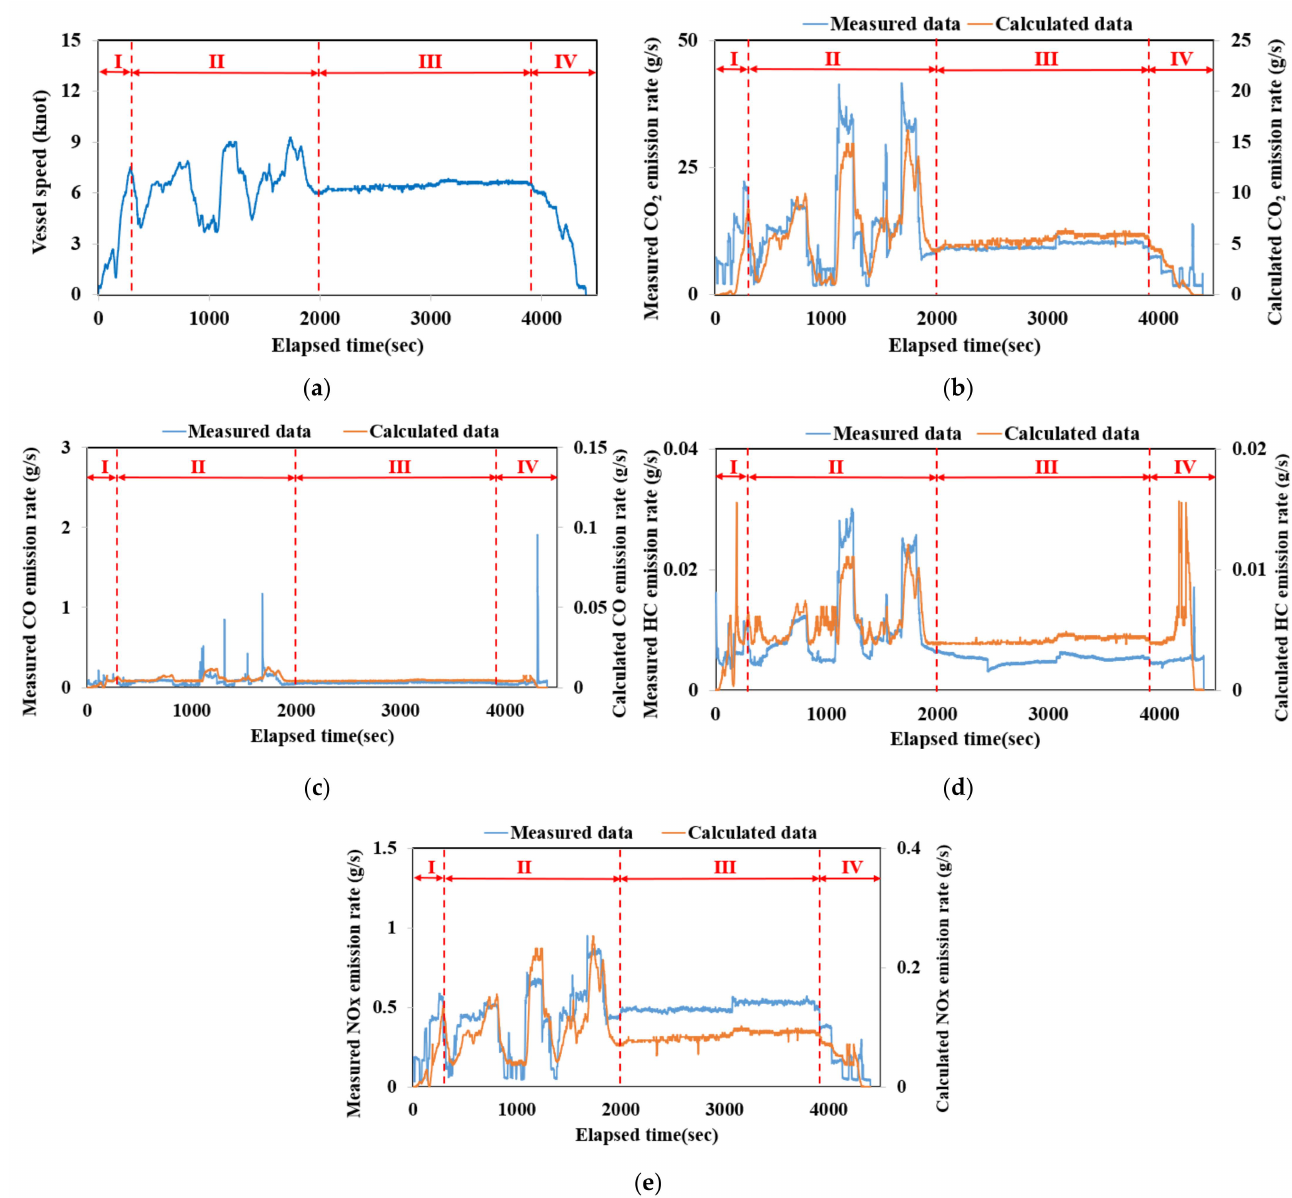
Figure 2. Instantaneous vessel speed and emission rates of tested ship No. 2 from onboard emission test data and calculated data from the AIS-based emission mode. Cycle I is the port departure mode; cycle II is the special cruise test mode which continuously accelerates and decelerates on the safe vessel cruise speed range; cycle III is the normal cruise mode; cycle IV is the port arrival mode. ( a ) The instantaneous vessel speed conditions of the whole cycle; ( b ), ( c ), ( d ), ( e ) The comparison of measured data and calculated data of CO 2 , CO, HC, and NOx,